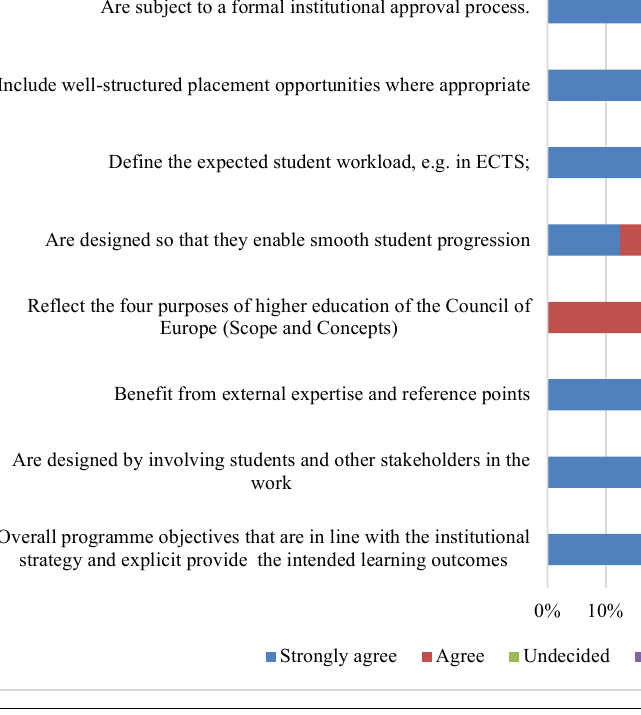
Figure 3: Design and approval of programs in Kosovo